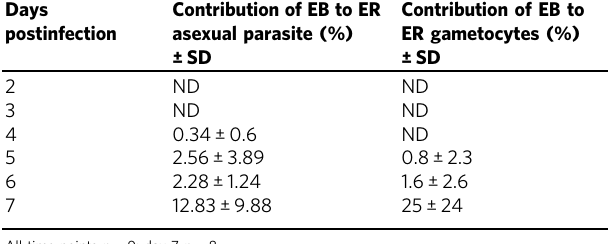
Table 1 Mean percentage contribution of EB parasites to the ER asexual parasite population 24 h later in BALB/c mice Days